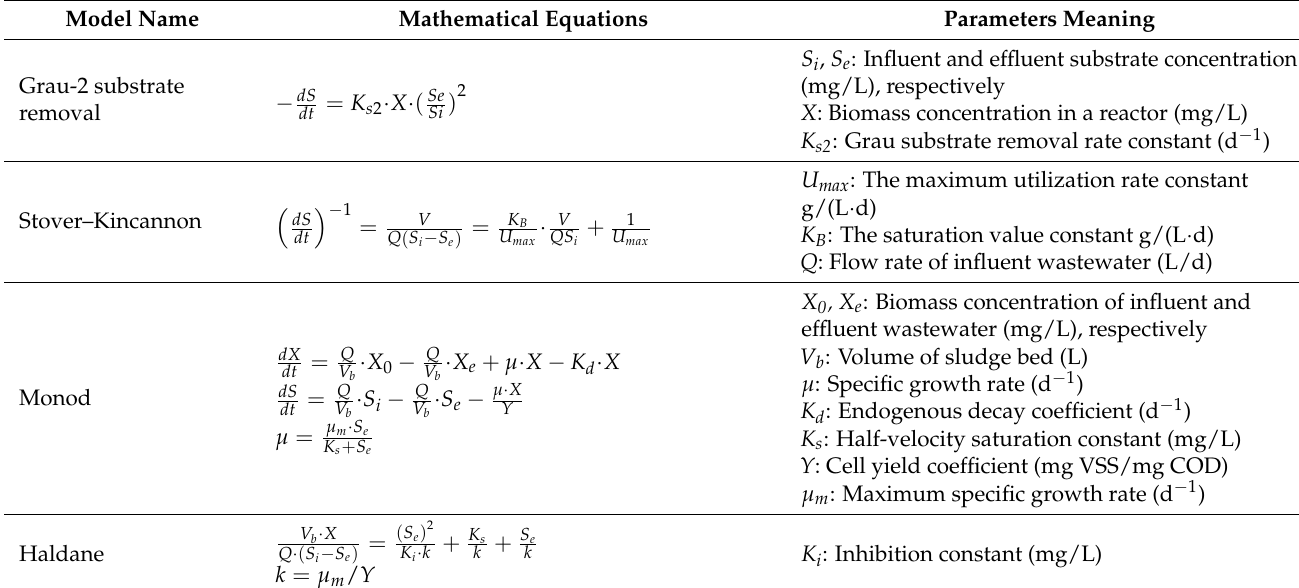
Table 3. The kinetic models used in this